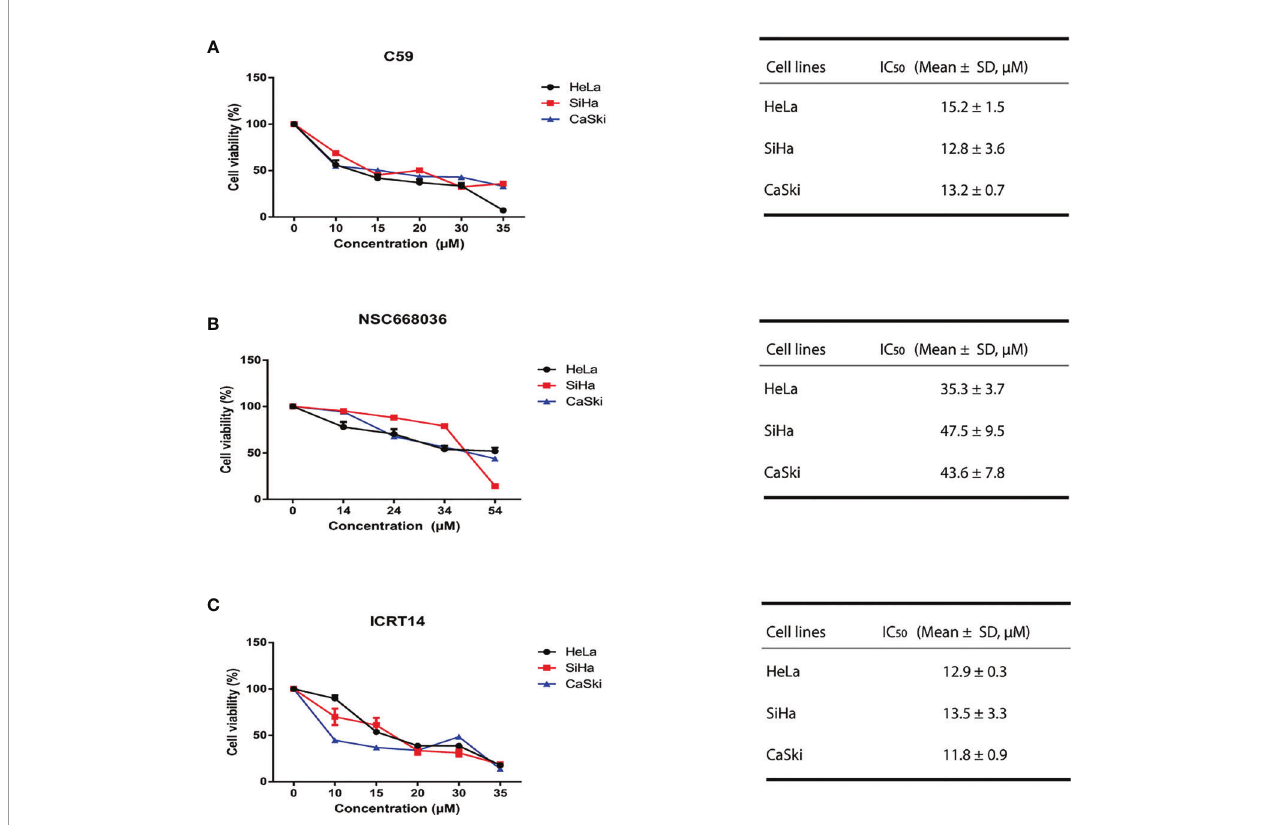
FIGURE 4 | C59, NSC668036 and ICRT14 decrease proliferation of CC cells. HeLa, SiHa and CaSki cells were treated with different doses of (A) C59, (B) NSC668036 and (C) ICRT14 for 24 hrs. Cell viability was analyzed using MTT. IC50 was determined by non-linear